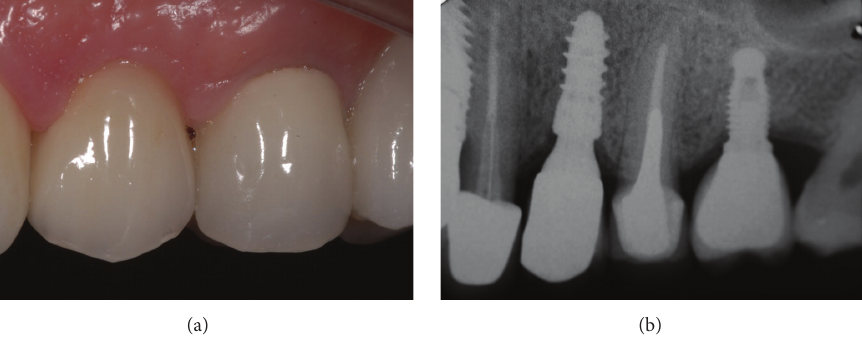
Figure 5: A single 3DP/AM titanium dental implant in a postextraction socket of the posterior maxilla: 3-year follow-up control. (a) Clinical picture after 3 years of functional loading. (b) Periapical rx after 3 years of functional